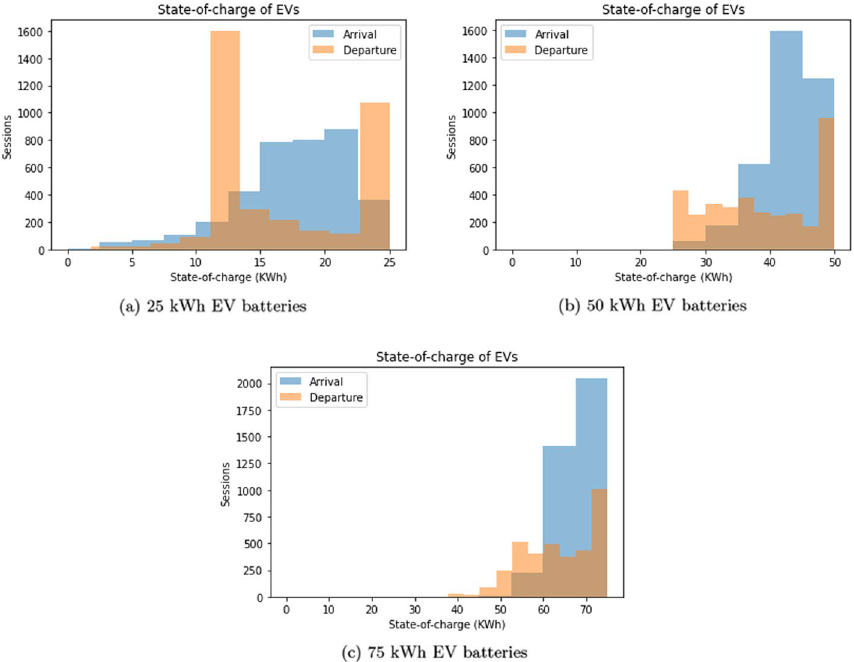
Fig. 6 State-of-charge distributions at time of arrival and departure. Two-way charging with ‘borrowing’ in a residential setting (matching renewable